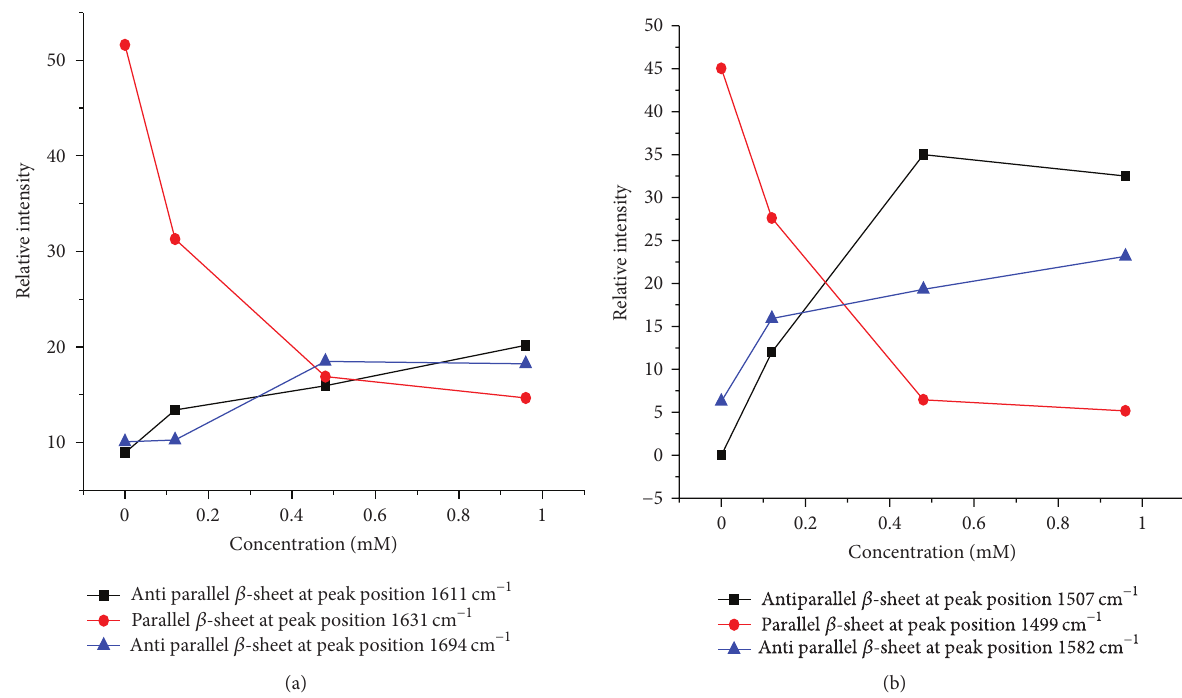
F 7: Relative intensity variation for different concentrations of TTR-pentobarbital complexes in (a) amide I region and (b) amide II region.